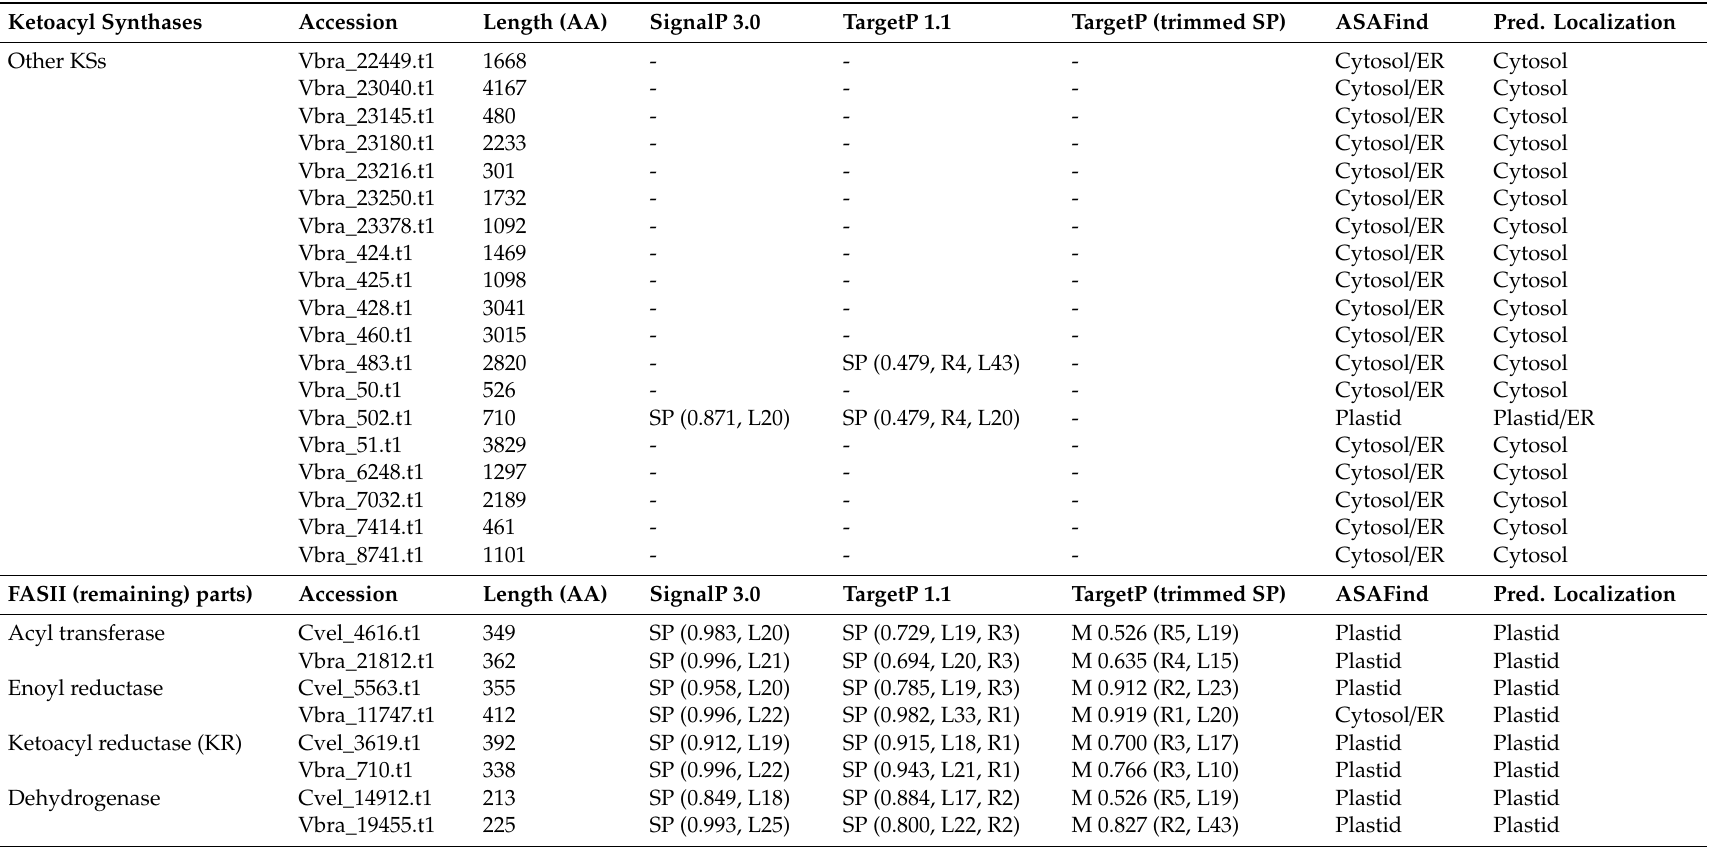
Table 3. Ketoacyl synthases, elongases, and desaturases in chromerids and their predicted subcellular